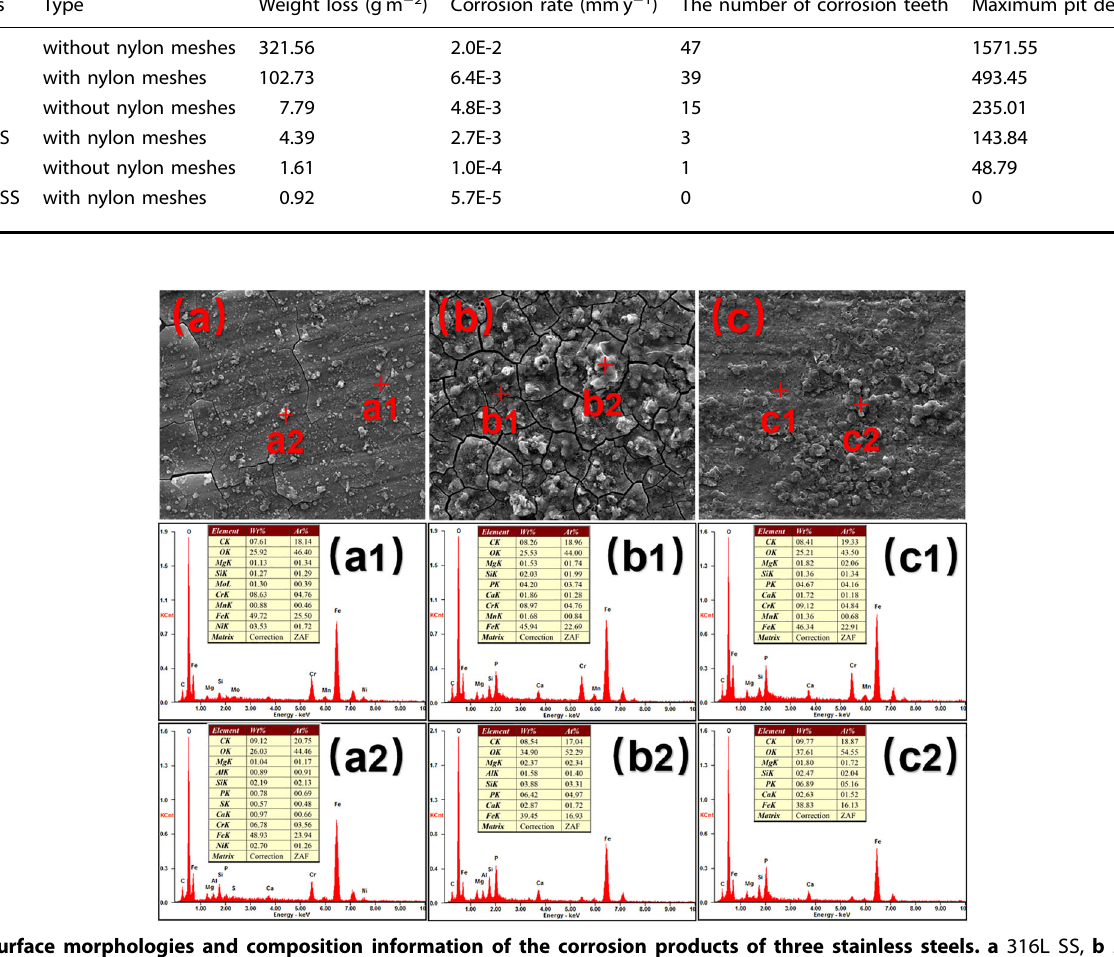
Table 1. Statistical results of crevice corrosion on samples without and with nylon meshes after immersing for 24 months. Materials